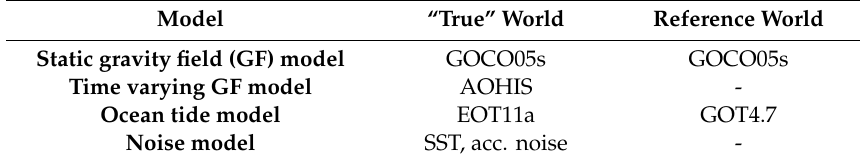
Table 3. Force and noise models of the “true” and “reference” world used in the full-scale simulations.